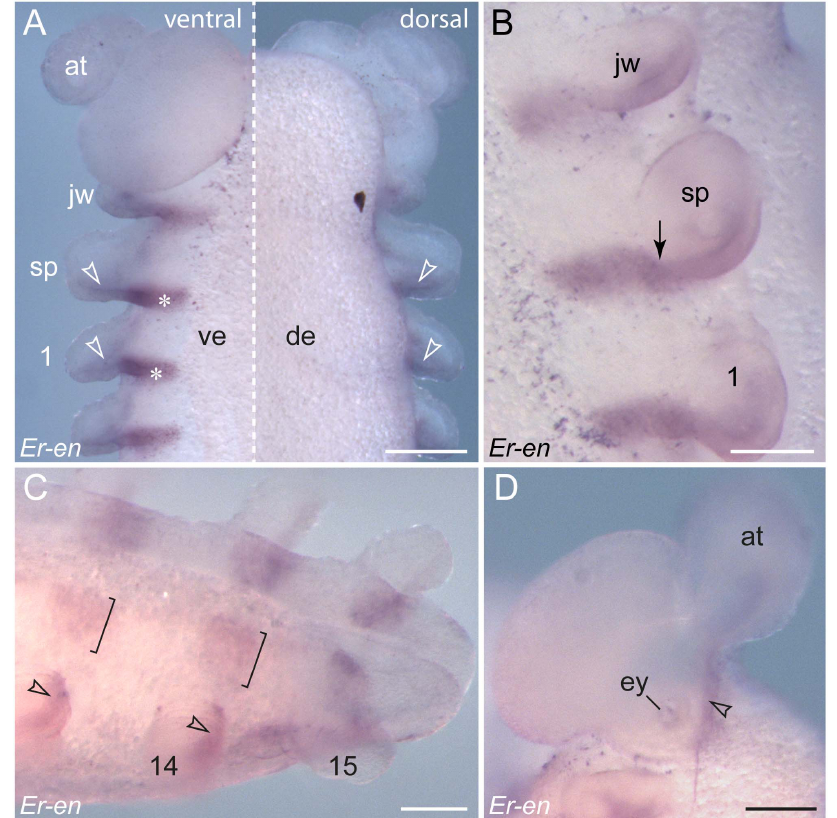
Figure 4. Details of engrailed expression in embryos of E. rowelli . Leg-bearing segments and corresponding limbs are numbered. (A) Ventral (left) and dorsal perspective (right) of the anterior end of a stage IV embryo. Note the expression in the ventral ectoderm (asterisks) and in the ectoderm and mesoderm of each developing limb (arrowheads). (B) Details of the anlagen of a jaw, a slime papilla and the first leg in a stage IV embryo. Arrow points to the transition between a wide ventral stripe and a narrow domain within the limb, which become separate during further development. (C) Ventro-lateral view of the posterior end of a stage V embryo. Note that the domains within the limb buds (arrowheads) and those on the ventral body surface (square brackets) have become separate. The latter correspond to the anlagen of the ventral and preventral organs [30,42,56]. (D) Lateral view of a developing antenna in a stage IV embryo. Abbreviations: at , developing antenna; de , dorsal extra-embryonic tissue; ey , developing eye; jw , embryonic jaw; sp , embryonic slime papilla; ve , ventral extra-embryonic tissue. Scale bars: 250 m m (A), 125 m m